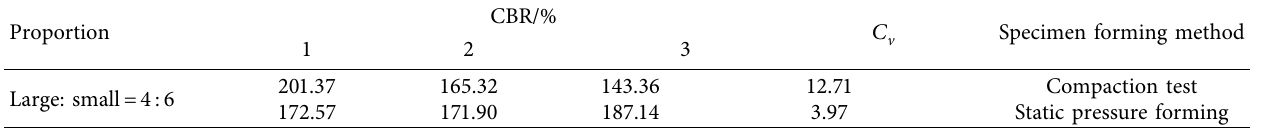
Figure 5: CBR test: (a) relationship between compactness and dry density, (b) relationship between compactness and CBR, and (c) relationship between compactness and swelling capacity. The error bars represent the standard deviation of measurements for 9 particles in three separate sample runs ( n � 27). Table 4: CBR values under different molding